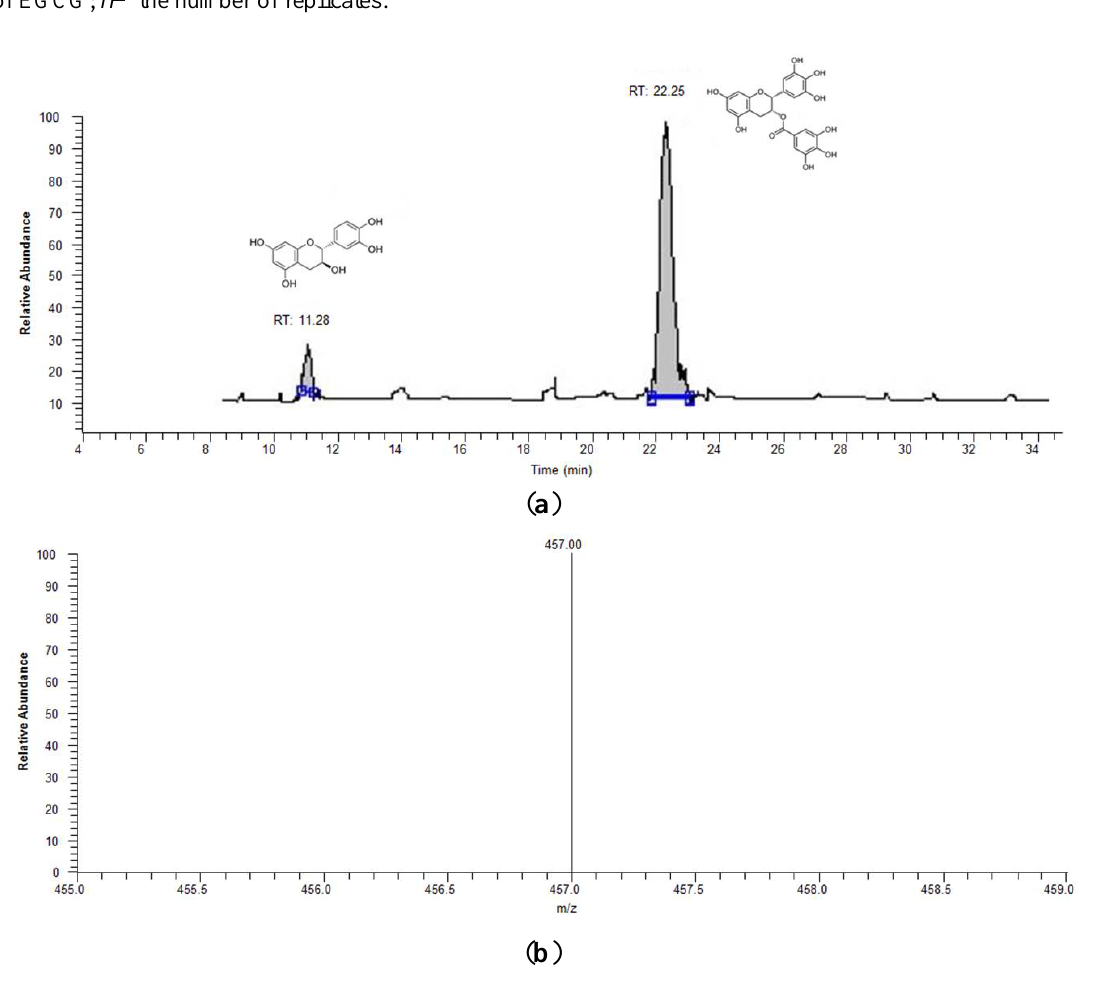
Figure 2. Typical chromatogram of the internal standard, (+)-catechin (100 ng/mL) and EGCG (500 ng/mL) analyzed by HPLC and ESI-MS set in negative polarity SIM mode. When the EGCG peak in ( a ) was selected the molecular ion for EGCG (molecular mass-1) was clearly seen at 457 m/z ( b